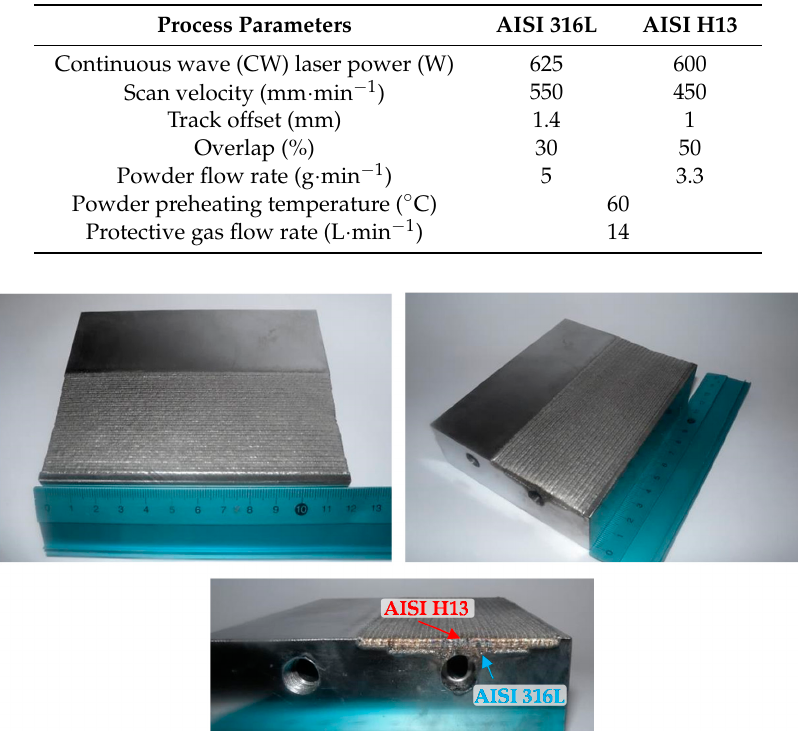
Figure 3. Deposition strategy of AISI H13.